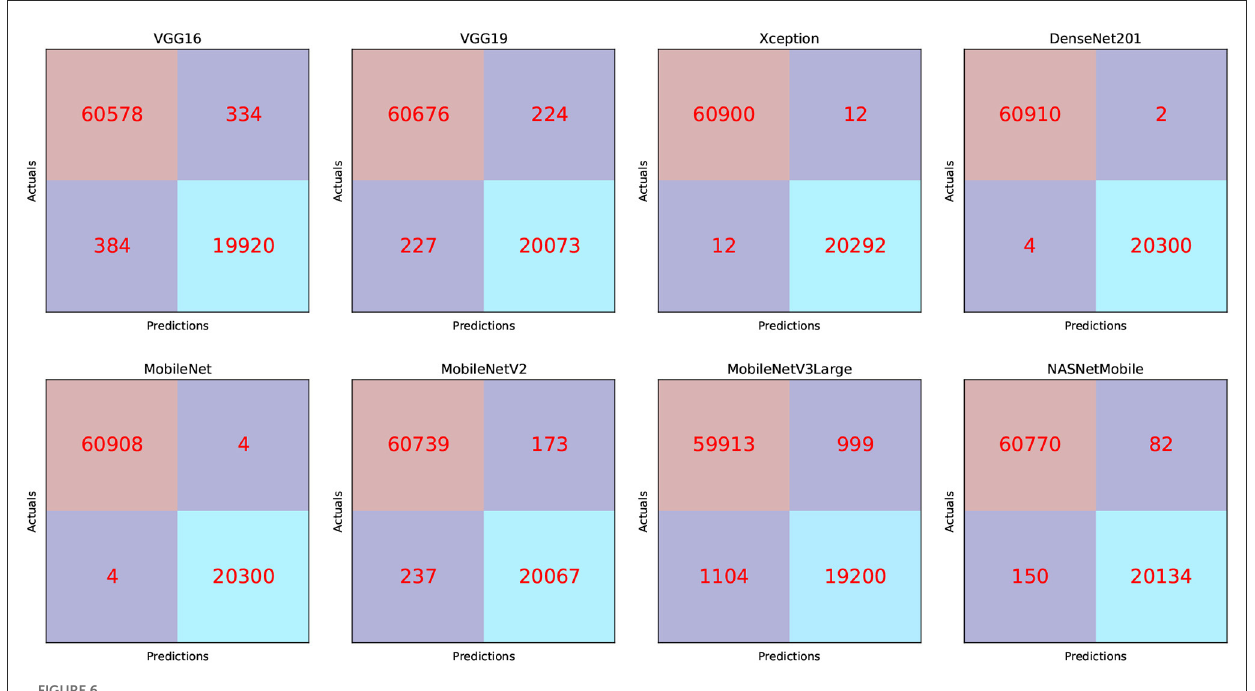
FIGURE6 CM related to the Four-classes